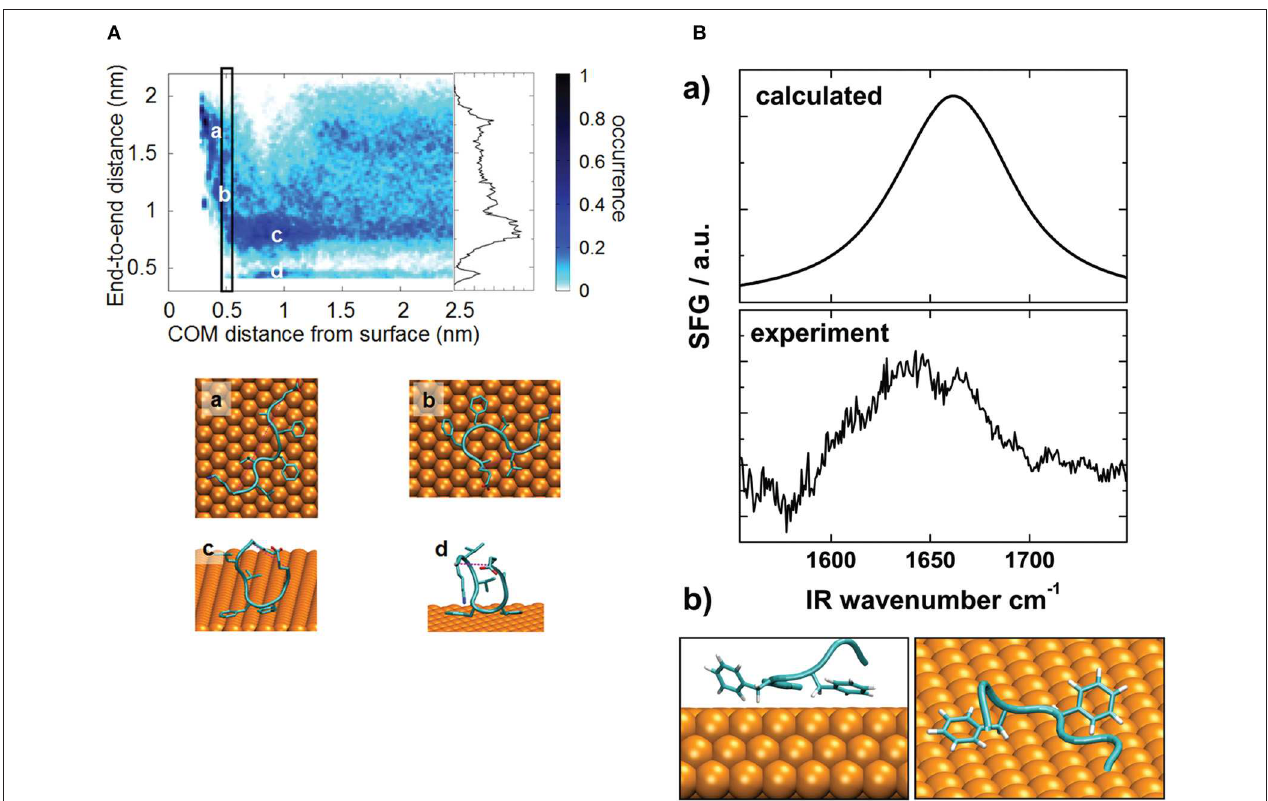
FIGURE 2 | (A) Distribution fraction of peptide end-to-end distance (computed considering terminal C α atoms) as a function of peptide–surface distance. The rectangle identifies the free energy minimum as a function of the peptide–surface distance. The inset represents the distribution of the end-to-end distance in the bulk region (COM distance from the surface larger than 1.25nm). (a–d) show representative conformations. (B) Comparison between calculated and experimental SFG spectra (a) and simulated structure used for spectral calculation (b). Reproduced from Bellucci et al. (2016) under a CC-BY 3.0 license. Published by the Royal Society of